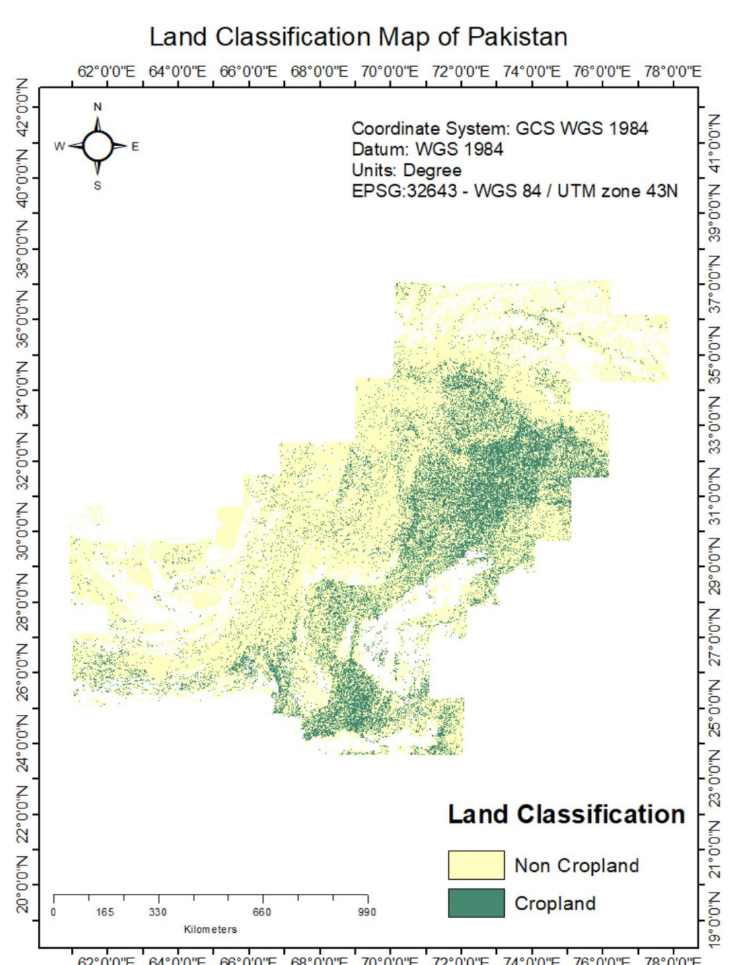
Figure 5. Land Classifications map of